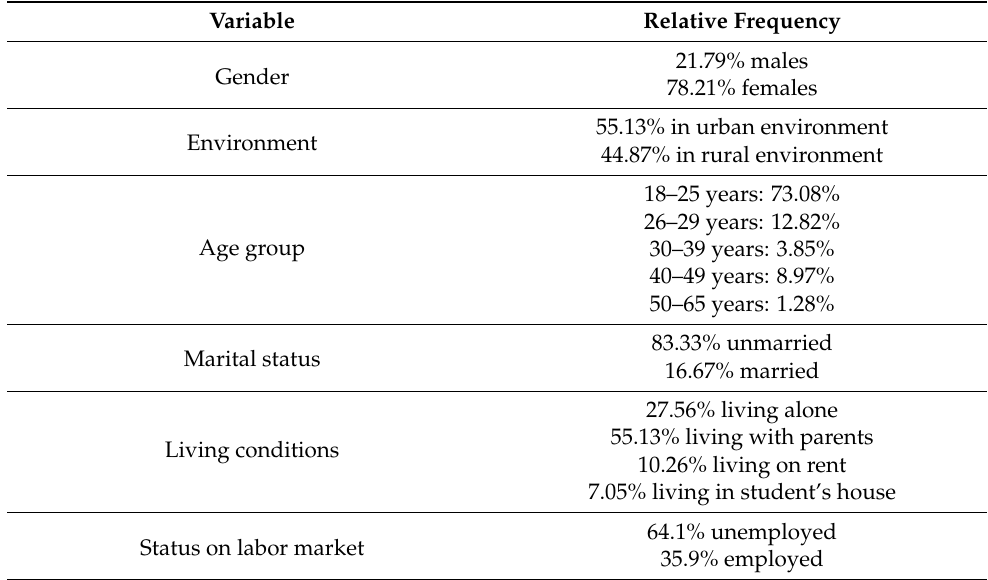
Table 1. Sample characteristics (overall sample, 526